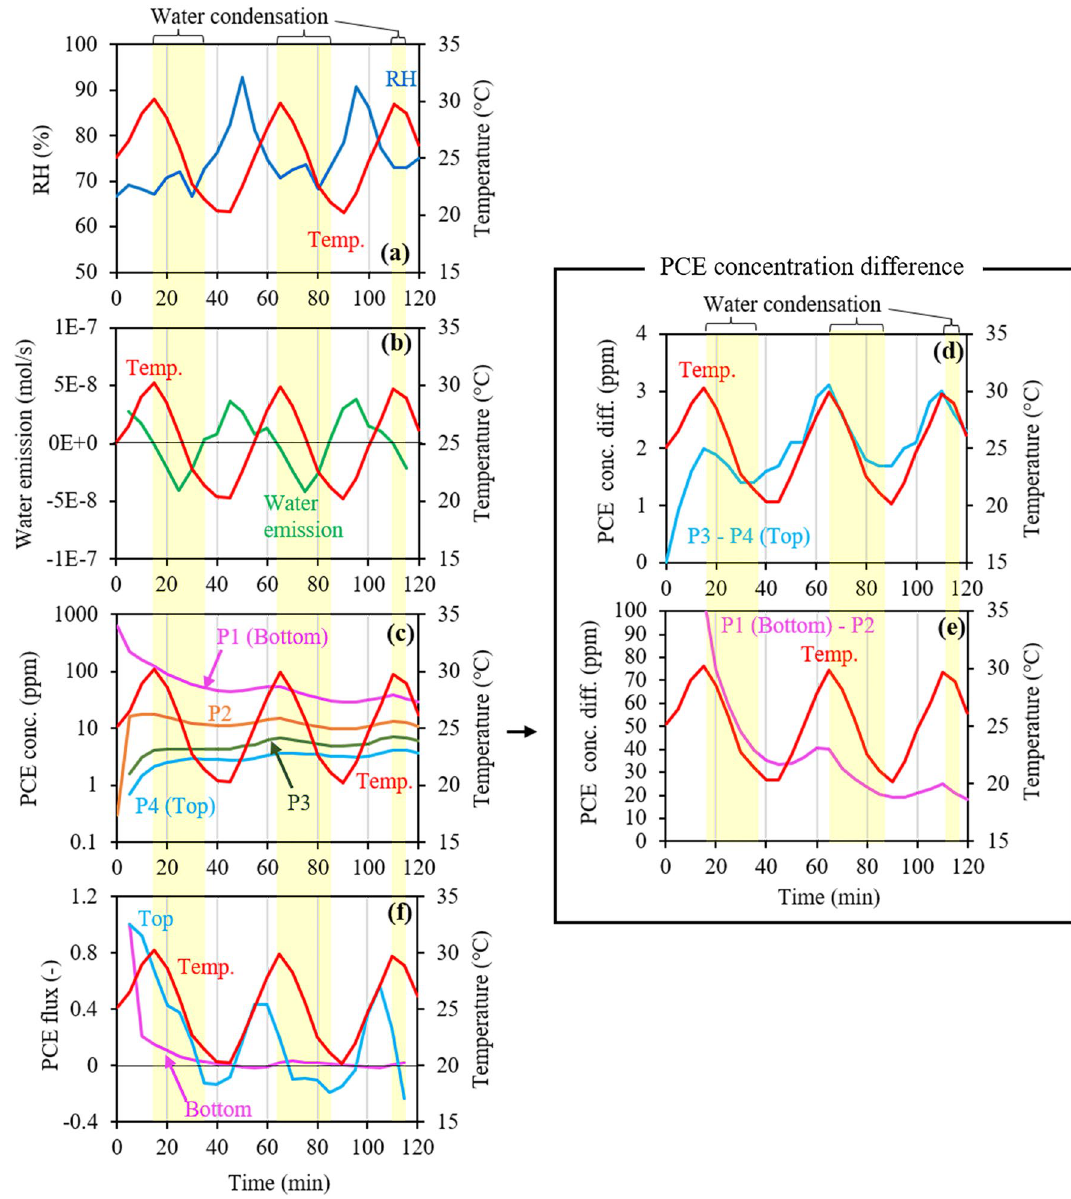
Figure 5. Changes in ( a ) relative humidity (RH) and ( b ) corresponding water emissions, ( c ) tetrachloroethylene (PCE) concentrations at the four ports (P1 ‒ P4), ( d , e ) corresponding upper and lower concentration differences, and ( f ) bottom and top PCE fluxes estimated from the concentration changes at P1 and P4, respectively, in Run 3 under dynamic temperature (20 ‒ 30 °C). Note that the flux value at each time is represented by a ratio of the observed value at each time to the largest observed